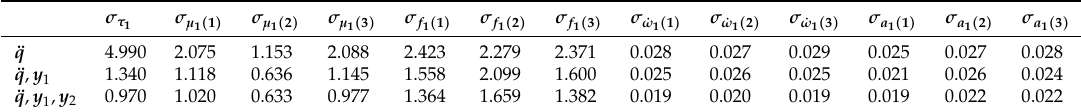
Table 2. Standard deviation of estimated variables for link 1.